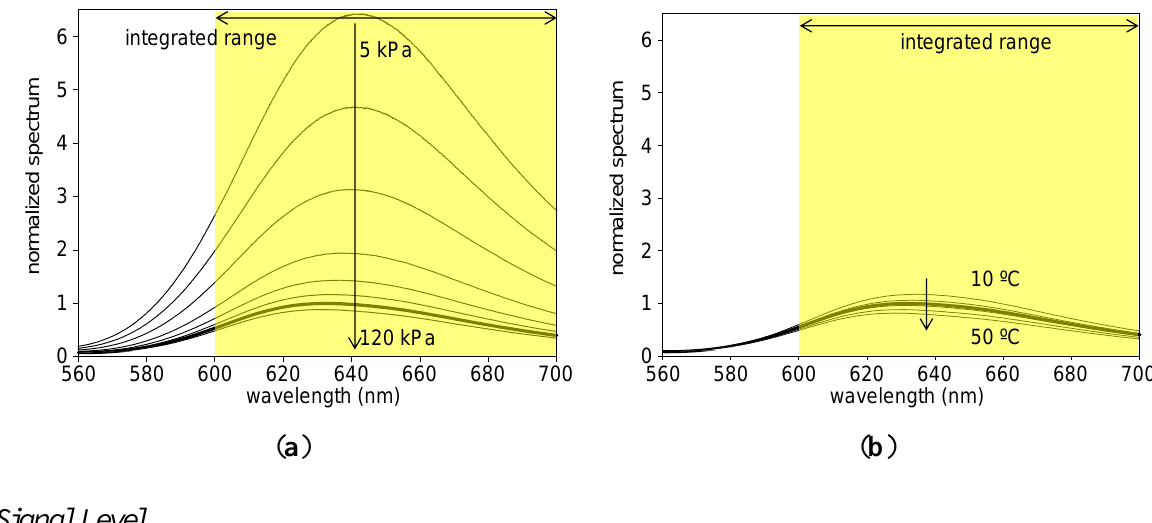
Figure 6. ( a ) Pressure spectra and ( b ) temperature spectra of PCPSP the spectrum at the reference conditions of 100 kPa and 25  C.